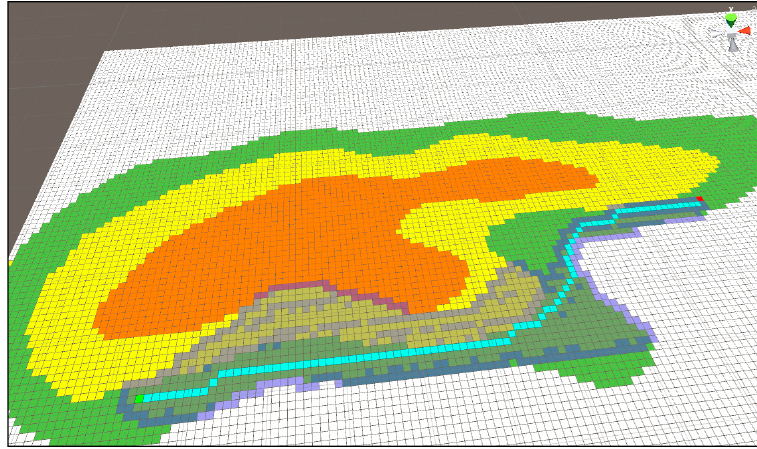
Figure 23. The shortest distance search method while keeping the current terrain as far as possible using Dijkstra Algorithm (2).